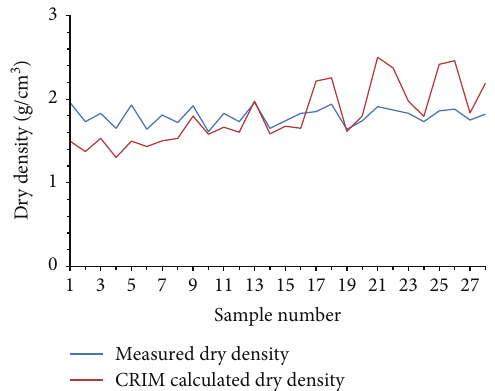
Figure 17: The measured soil sample dry density and predicted dry density by the complex refractive index model